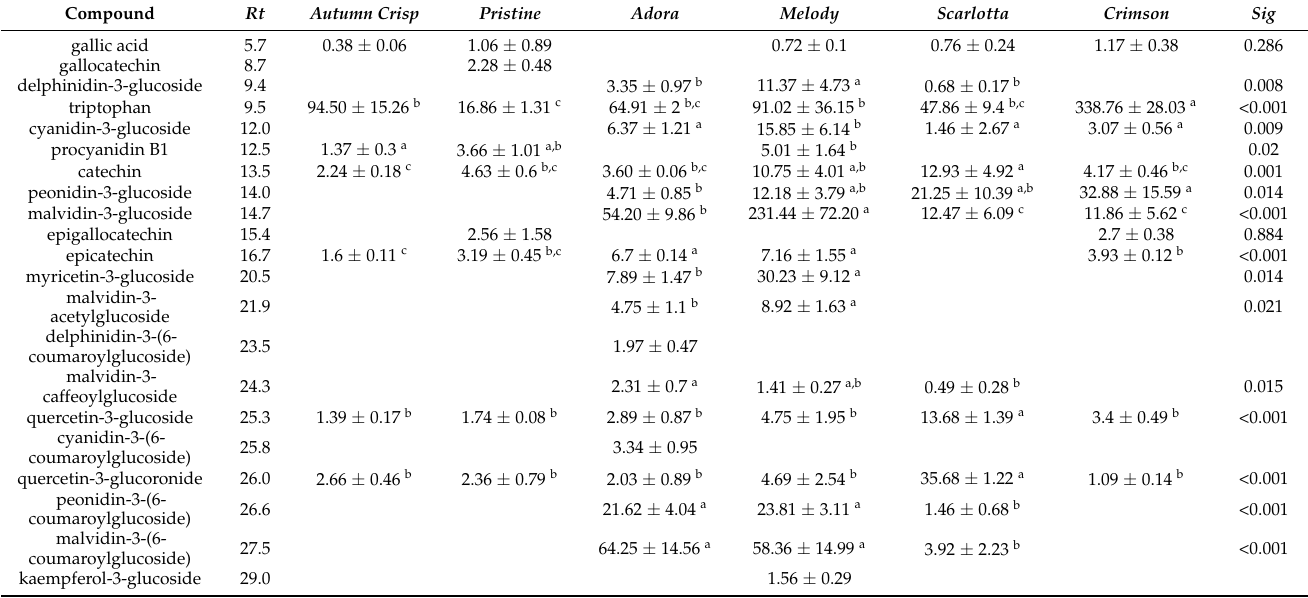
Table 2. Seedless grapes quantitative composition (mean ± SD, µ g/g FW)